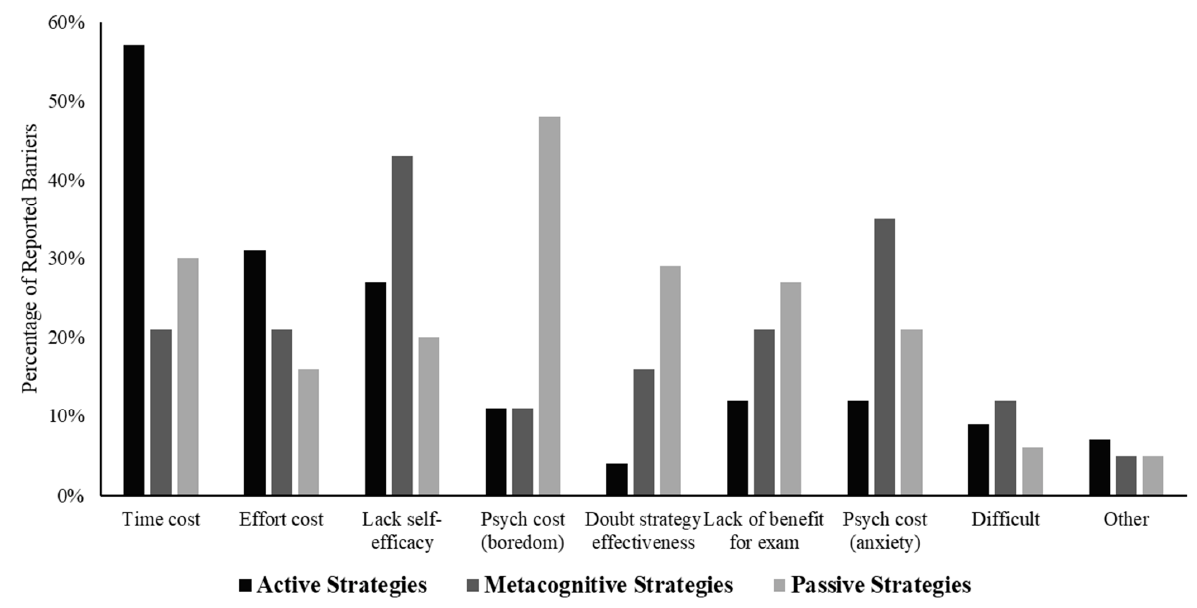
Figure 4. Percentage of reported barriers per vignette.